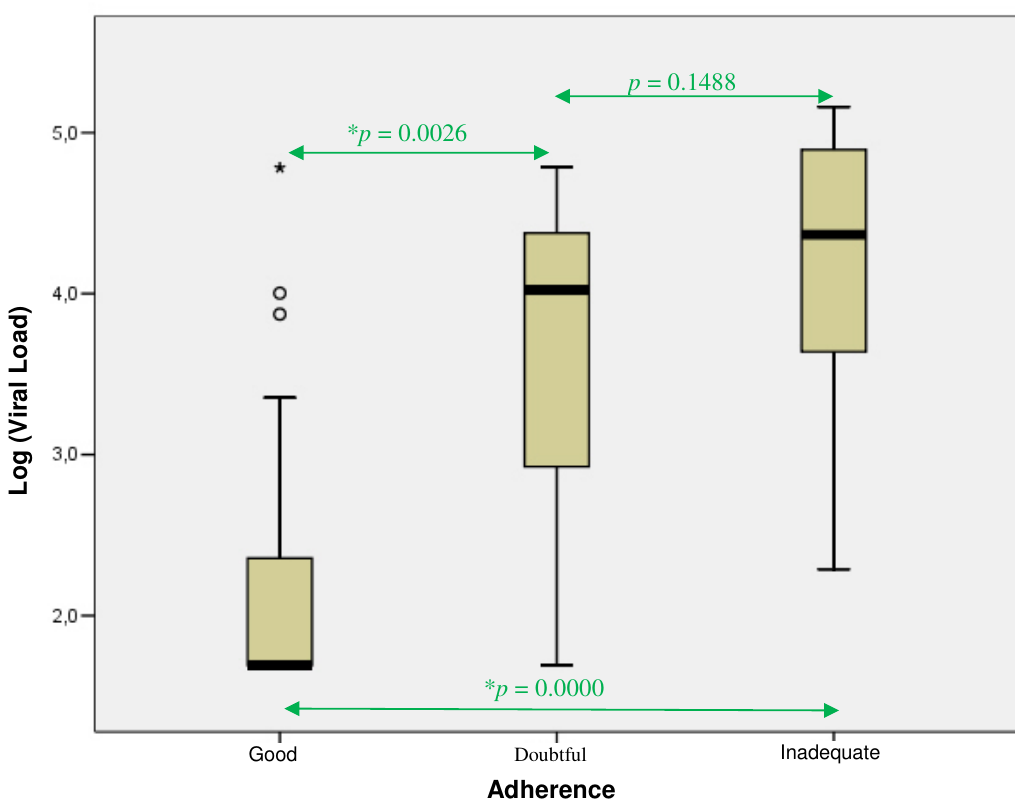
FIGURE 1. Boxplot showing viral load distribution consistent with therapy adherence. * p < 0.05 = statistically